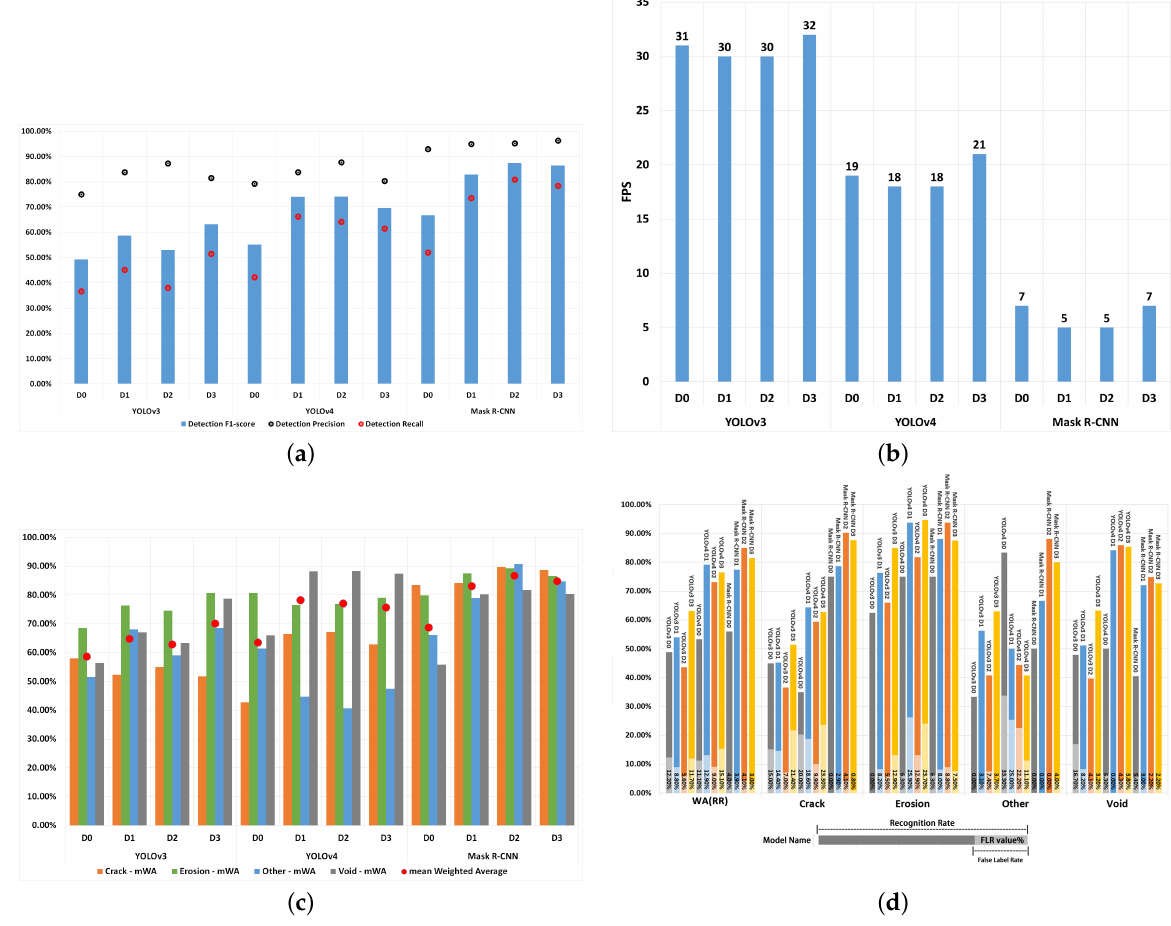
Figure 3. Performance Evaluation Diagrams for YOLOv3, YOLOv4 and Mask R-CNN. ( a ) Traditional Performance Evaluation. ( b ) Detection Speed Evaluation. ( c ) mean Weighted Average Performance Evaluation. ( d ) RR and FLR